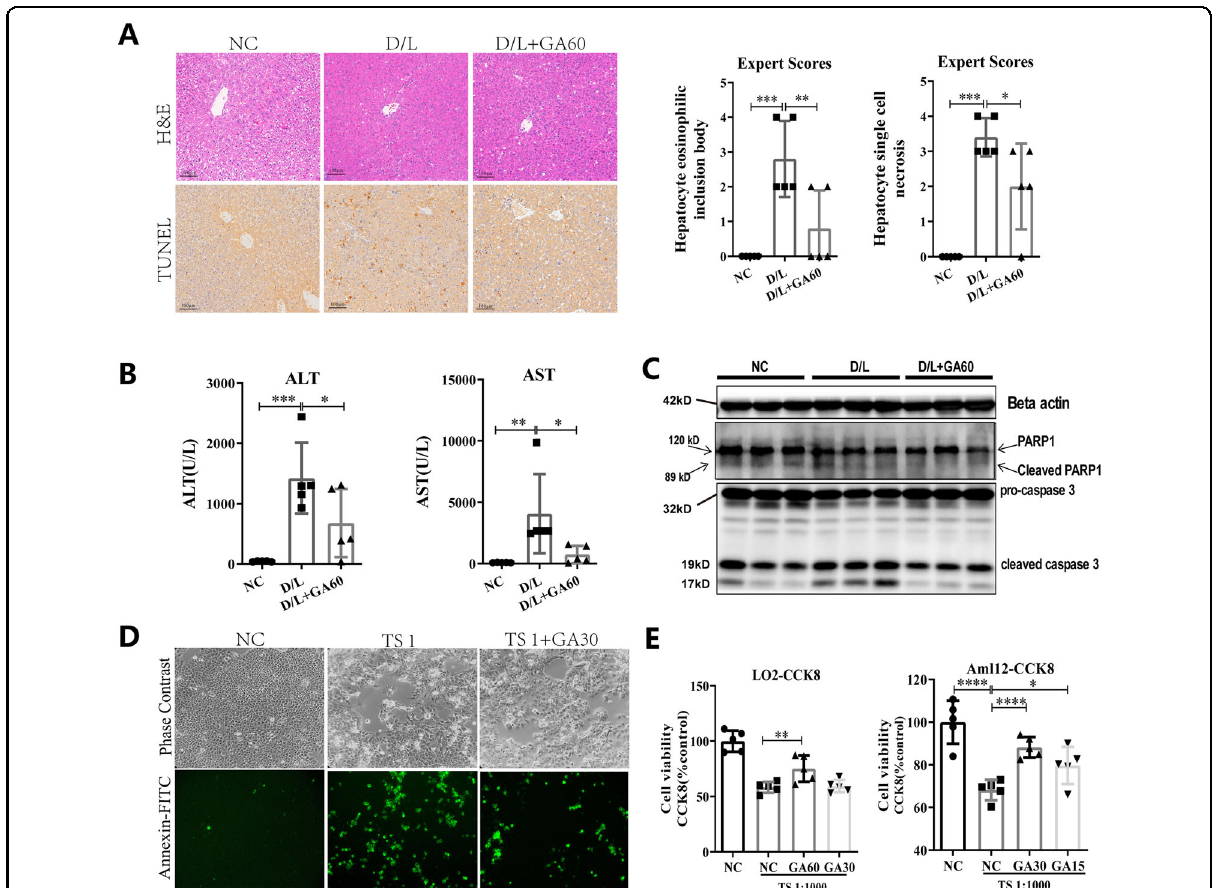
Fig. 1 Effect of GA on acute liver injury in vivo and in vitro. SD rats were intraperitoneally administered GA (60 mg/kg) or vehicle for 5 days, and then treated with 800 mg/kg D-GalN plus 30 μ g/kg LPS for 24 h ( n = 5). H&E and TUNEL stained liver slices and corresponding histological scores ( A ), plasma liver enzymes ALT, AST ( B ), and hepatocyte apoptosis ( C ) in rat livers were detected. Cells were treated with TS (1 μ l/ml, C0006S, Beyotime) and with or without GA ( μ M) for 24 h, the cell viability was measured by using FITC fl uorescence in LO2 cells ( D ) and CCK-8 in LO2 and Aml 12 cells ( E ). Data represent three independent experiments. Data are shown as mean ± SD, statistical signi fi cance: * P < 0.05, ** P < 0.01, *** P < 0.001, **** P <